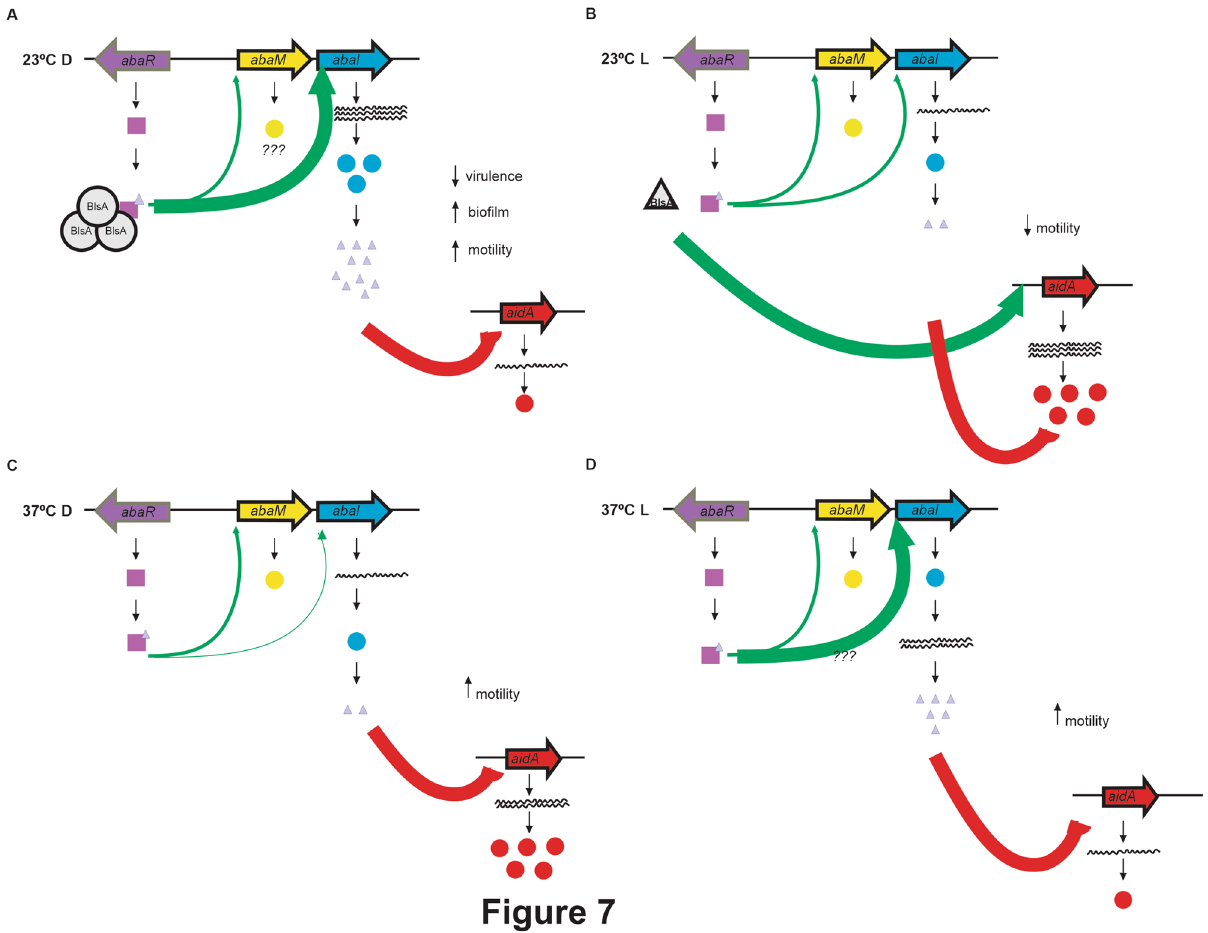
Figure 7. Working model depicting current knowledge regarding modulation by light of quorum sensing in A. baumannii . At environmental temperatures such as 23 °C, the photoreceptor BlsA interacts with AbaR only in the dark most probably with the bound AHL, inducing expression of the abaI gene and the production of AHL at this condition. At environmental temperatures such as 23 °C but in the presence of light, BlsA does not interact with AbaR, most likely because it is in a non-permissive conformation. Interestingly, BlsA induces of expression of AidA, reported as a lactonase, in the in the presence of light but not in the dark. This is consistent with the increased quorum quenching activity observed in the presence of light, which is even more deepened in the ΔabaI mutant. The overall result is the presence of higher levels of AHL in the dark than under blue light ( A , B ). At 30 °C, and therefore we infer that neither does it at 37 °C, BlsA does not interact with AbaR, neither in the dark, nor under blue light ( C , D ), indicating that this photorreceptor is not involved in the quorum response at this temperature. abaI expression levels, as well as AHLs are higher in the presence of light than in the dark. Interestingly, aidA expression levels were induced in the dark and significantly increased in the abaI mutant both in the dark and under blue light indicating that AbaI or its products inhibit expression of the aidA lactonase. However, this was not reflected in a higher quorum quenching activity in the abaI determined by the use of the A. tumefaciens NT1 (pZLR4), C. subtsugae CV026 and C. violaceum VIR07 biosen- sors, in a BlsA and AbaI-dependent manner. In fact, AHL production followed motility and biofilm formation patterns in the different strains. In agreement, abaI expression was found to be stimulated in the dark, which followed AHL production. Surprisingly, despite significant and similar levels of AHLs were produced in the blsA mutant under blue light and in the dark, expression of abaI was low and similar to the wild type under blue light in this mutant, showing no correlation between abaI expression, motility and production of AHLs at environ- mental temperatures. A possible explanation for these results could be that BlsA modulates the “timing” of abaI expression. Then, abaI expression could have been significant in the blsA mutant both under blue light and in the dark in a time lapse previous to sample recovery, allowing thus AHLs production and motility, and could have decreased reaching minimal expression latter, which is typical of the expression of AHL synthase genes. Quorum quenching activity was found to be higher under blue light than in the dark at environmental temperatures, in a BlsA dependent-manner. Consistently, expression patterns of aidA, reported to function as a lactonase 30 , are also in agreement with the AHL pattern under blue light and darkness. In particular, aidA expression was found to be induced under blue light at environmental temperatures, which is consistent with the null or reduced presence of AHLs and increased quorum quenching activity detected in this condition. TLCs and GC–MS confirmed the